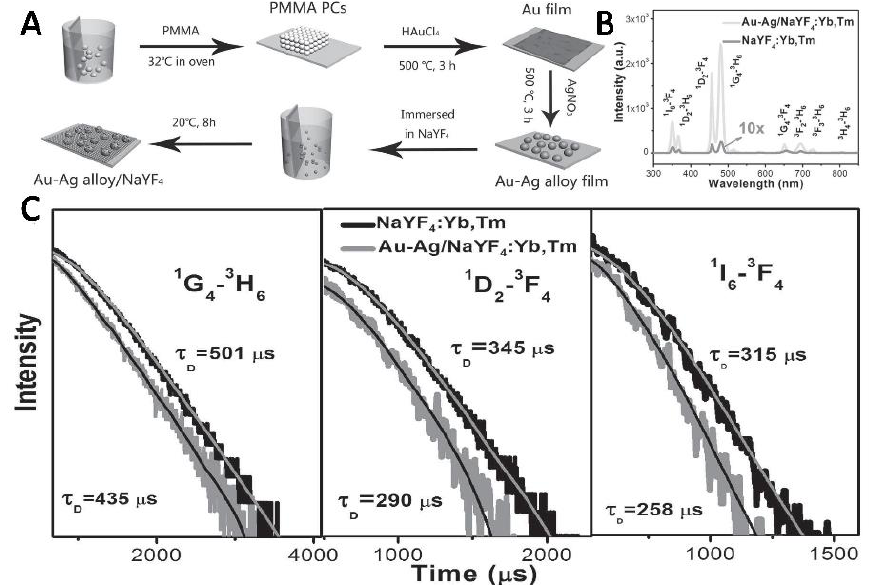
Figure 3. ( A ) Schematic diagram of the porous Au–Ag/NaYF 4 : Yb 3+ , Tm 3+ composite film. ( B ) The UC luminescence(UCL) spectra of sample without and with Au–Ag films. ( C ) The UCL decay curves of different transitions when the samples were excited at 980 nm. Reference [53].